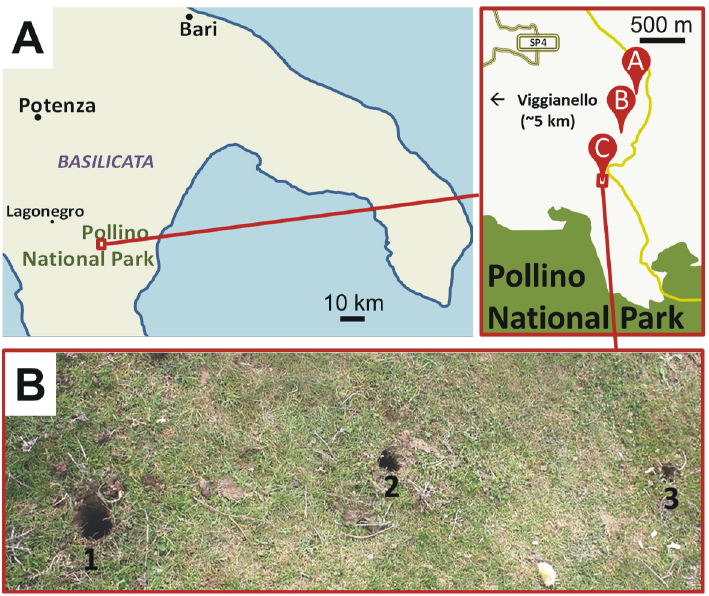
Fig 2. Location and details of sampling sites in southern Italy. Panel A indicates the locations of burial sites in Southern Italy (left) and positions of burial sites A, B and C at Pollino National Park (right). Panel B shows burial site C after sampling at positions 1, 2 and 3 (holes, approx. 50 cm apart).